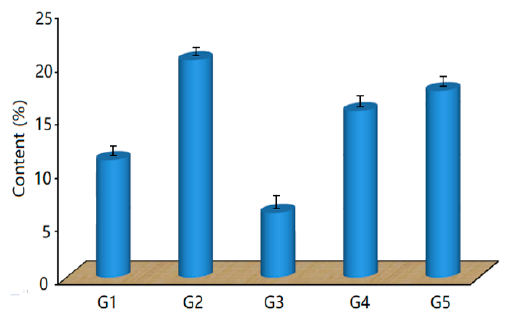
ff erent concentrations of graphene.